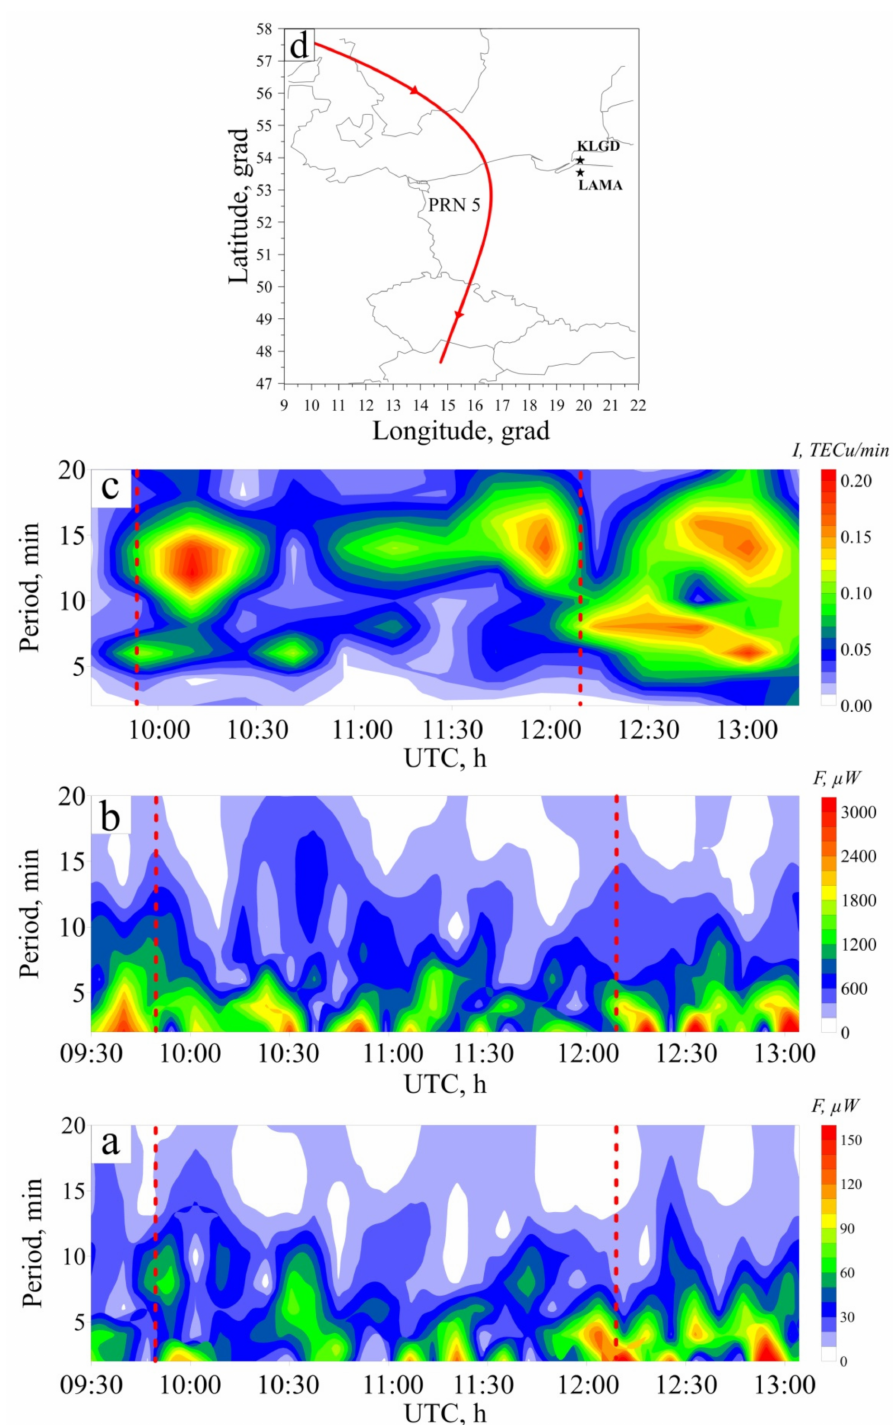
Figure 5. Spectra of variations in the troposphere ( a , b ) and ionosphere ( c ) parameters during the solar eclipse on 20 March 2015. Lidar measurements were carried out by the KLGD station at wavelengths: ( a ) λ 1 =1064 nm; ( b ) λ 2 = 532 nm. Propagation beam length is L m = 5000 m. Satellite GPS measurements were performed at the mid-latitude station LAMA. The red dotted lines indicate the beginning (9:50 UTC) and the end (12:10 UTC) of the solar eclipse. The upper part ( d ) of the figure shows the projection of the PRN 5 satellite trajectory corresponding to the time scale of satellite measurements. Arrows indicate the direction of the satellite